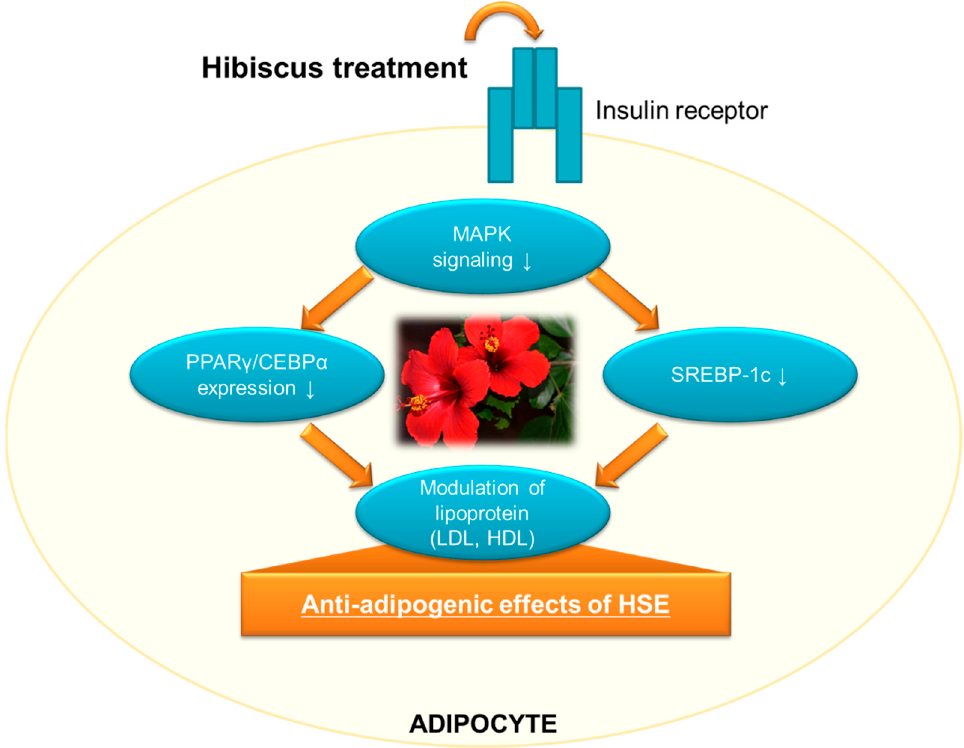
Figure 2. Anti-adipogenic effects on HSE through different pathways.